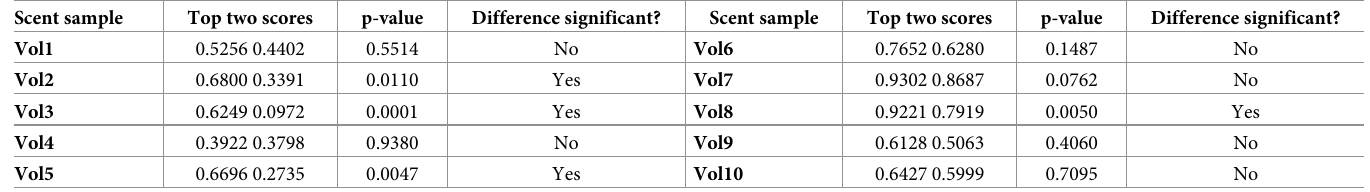
Table 1. Test for the significance of the difference between top two Spearman correlation scores for each cartridge sample. Scent sample Top two scores